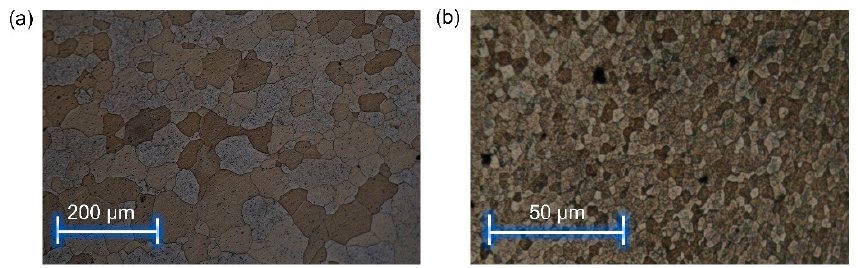
Figure 8. Grain structure of ( a ) reference wire, ( b ) wire produced with the friction-induced recy- cling